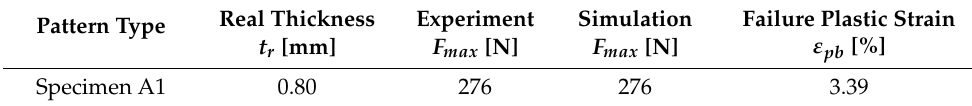
Table 9. Comparison of failure load F max from experiment and simulation.